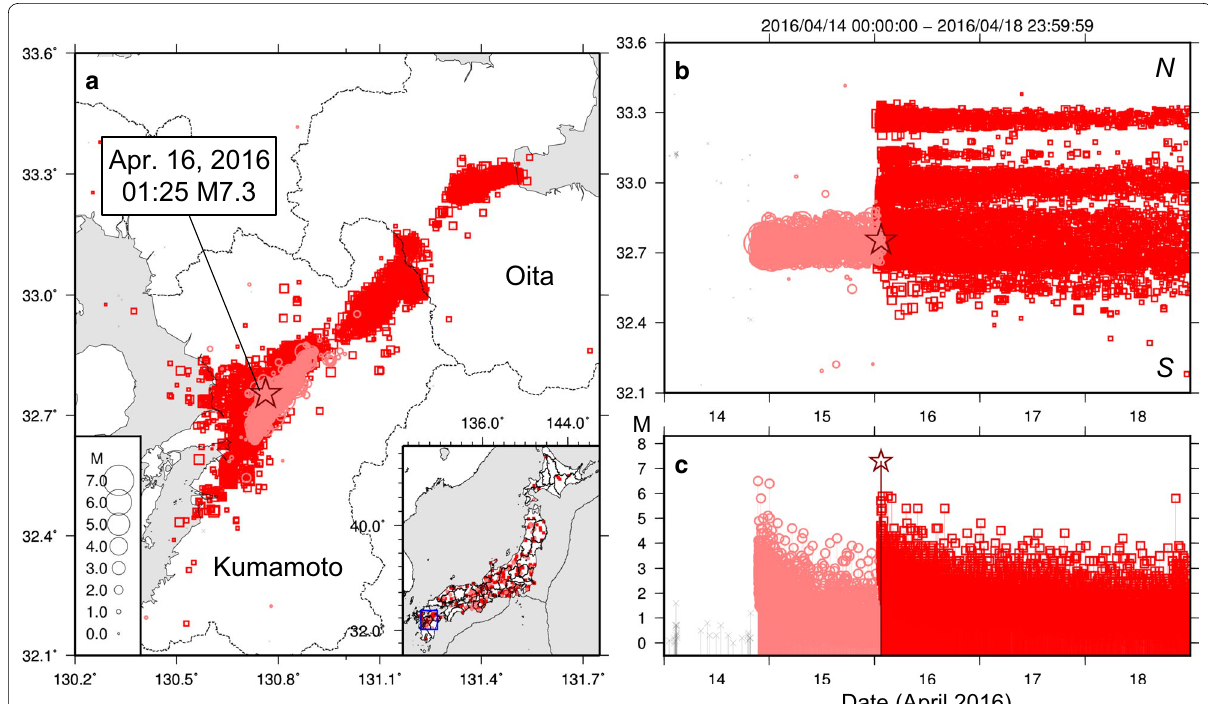
Fig. 3 Space–time–magnitude distributions of the 2016 Kumamoto earthquake sequence. a Epicentral distribution, b spatiotemporal distribu- tion, and c magnitude versus time diagram. The light red open circles, red squares, and dark stars indicate foreshocks, aftershocks, and mainshock, respectively. The gray dots represent other clusters or